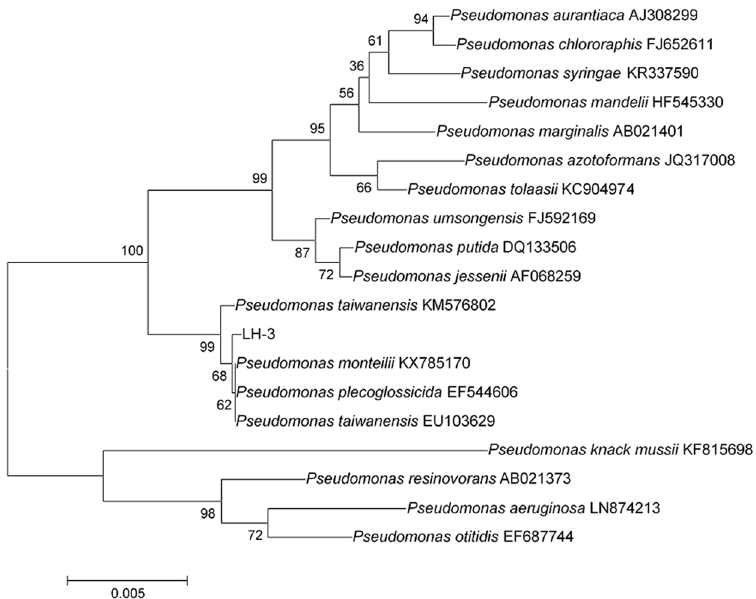
Figure 2. Phylogenetic tree based on the 16S rRNA gene sequences of strain LH-3 and the related species. The GenBank accession number for each microorganism used in the analysis was also given in the brackets. Bootstrap value obtained with 1000 samplings was indicated as percentage for the each branch. The scale bar indicated 0.005 substitutions per nucleotide